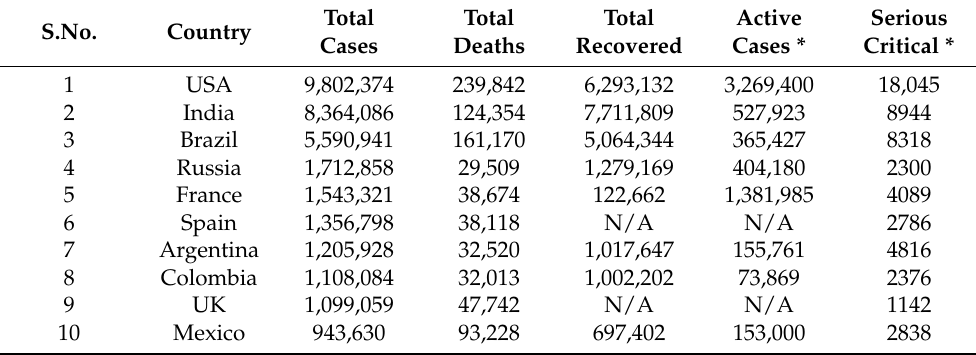
Table 1. Top 10 country-wise analysis of the count of COVID-19 related cases. S.No. Country